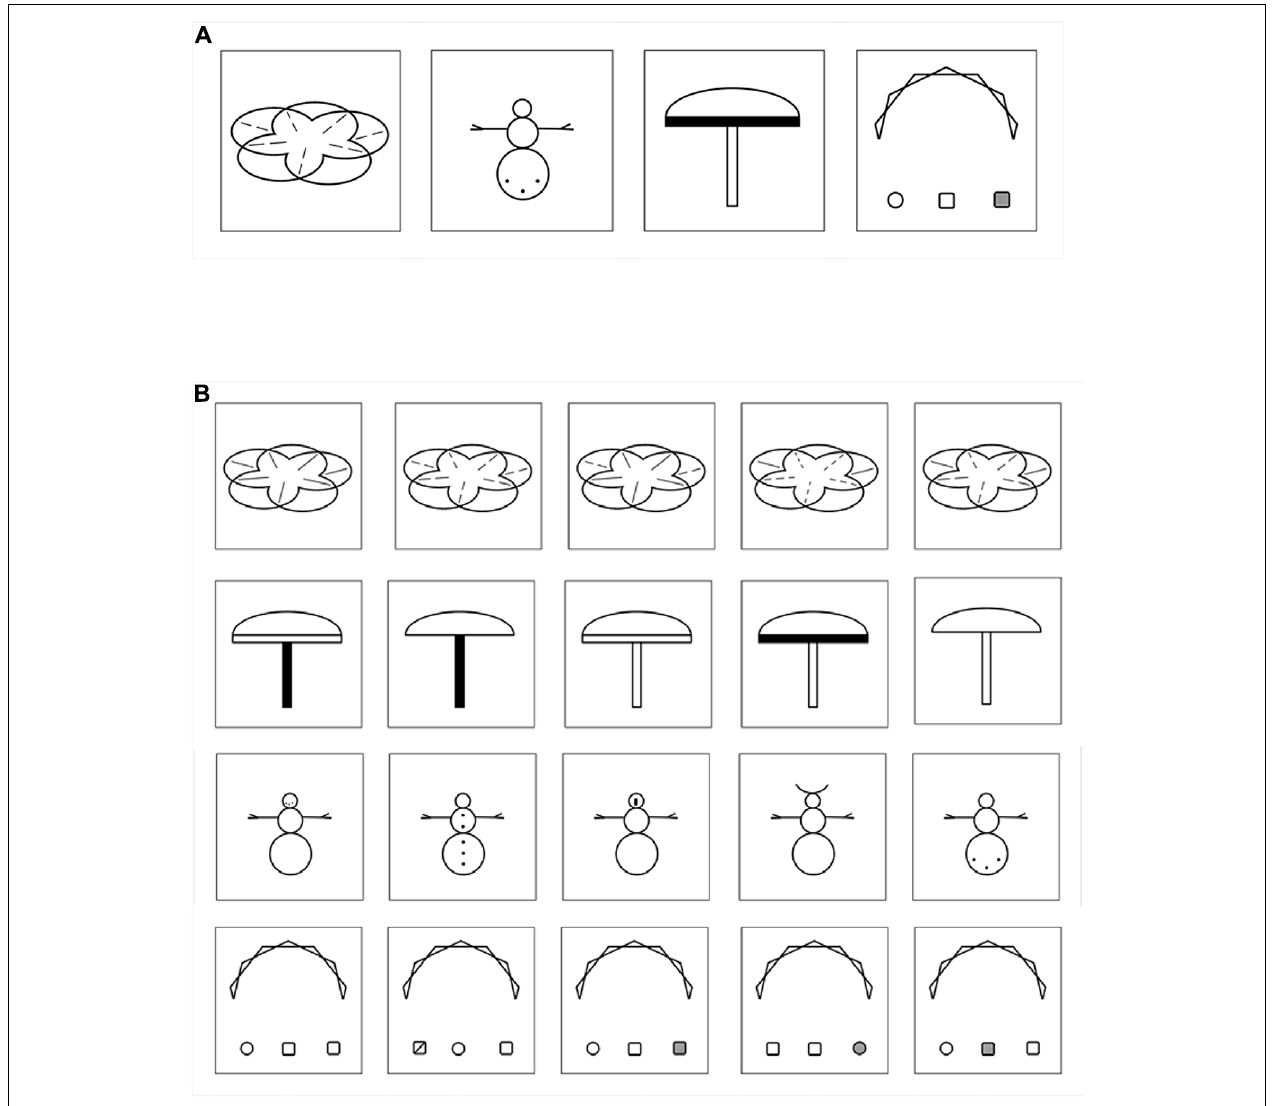
FIGURE 1 | (A) Four examples ofVLTM-D items presented in the encoding phase (5 s each). (B) Four examples of item arrays presented in the recognition phase. Each array consists of five items differing in small details,